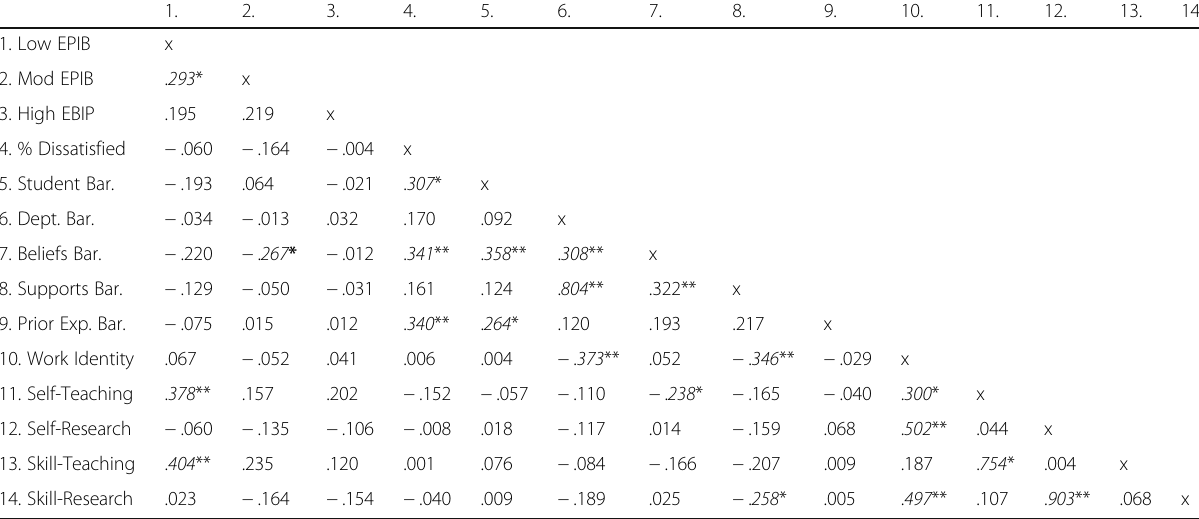
Table 10 Correlations between implementation of EBIPs, perceived barriers to implementation, and professional identity